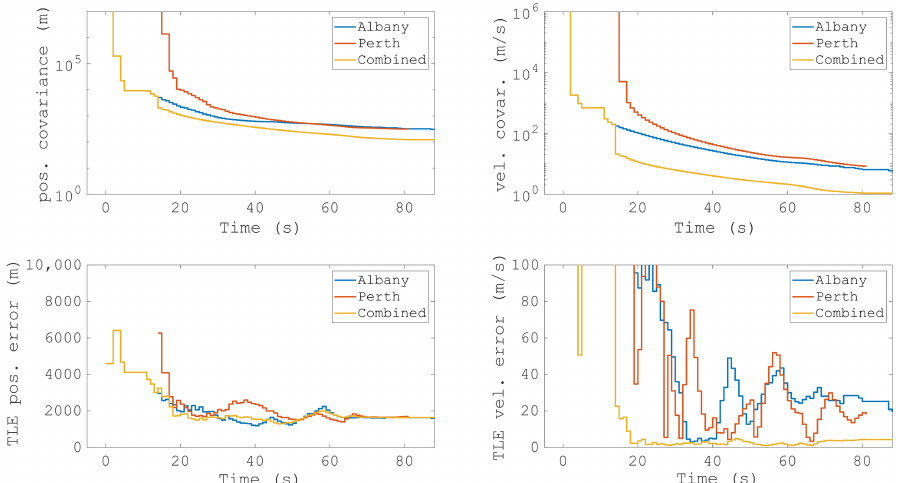
Figure 17. The resulting orbit predictions from the multistatic measurements from Figure 16. The top panels show the covariance of the position estimate and the velocity estimate. The bottom panels show the mean errors when compared with the two-line element (TLE).